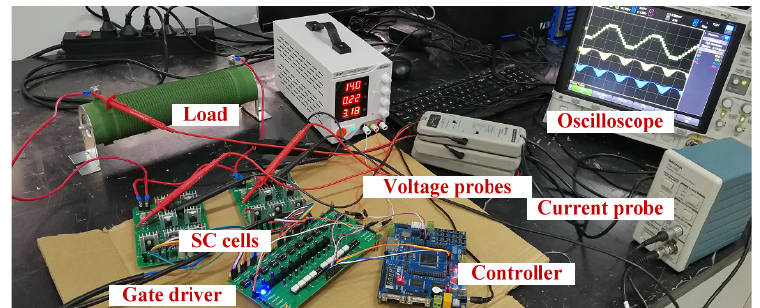
Figure 12. Experiment bench.